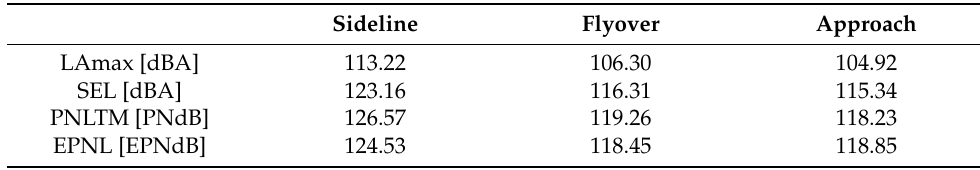
Table 5. Overall noise level at the three certification measurement point.